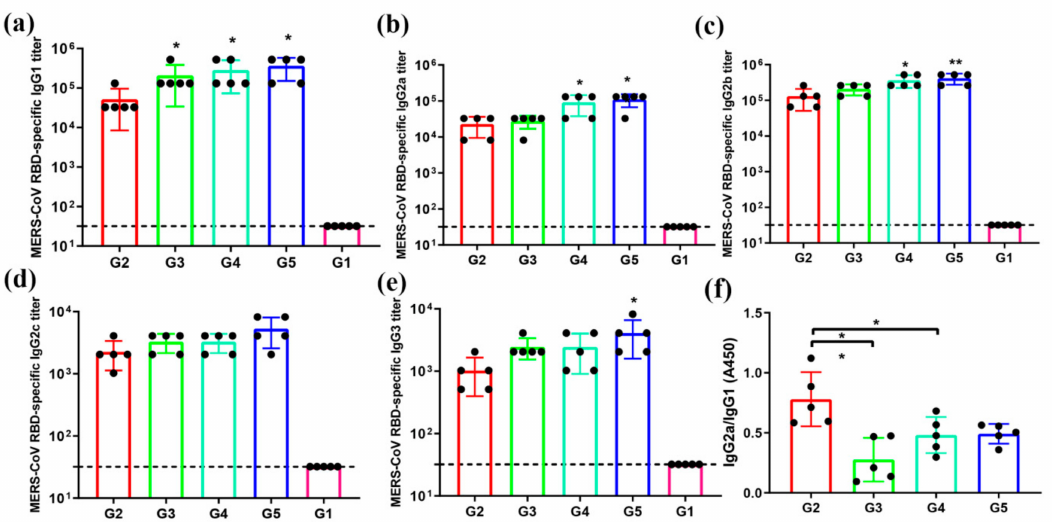
Figure 4. MERS-CoV RBD-specific antibody subtypes response. Sera from 2 weeks after the last immunization were tested for MERS-CoV RBD-specific IgG, IgG1, IgG2a, IgG2b, IgG2c, and IgG3 antibodies by ELISA. The data are shown as the mean ± SD from five mice in each group and were analyzed by Student’s t -test (* p < 0.05, ** p < 0.01, n = 5). The level of the MERS-CoV RBD-specific IgG1 ( a ), IgG2a ( b ), IgG2b ( c ), IgG2c ( d ), and IgG3 ( e ) antibodies were determined by ELISA and are shown as end-point dilution titers. The ratios between IgG1 and IgG2a antibody responses were also calculated ( f ).